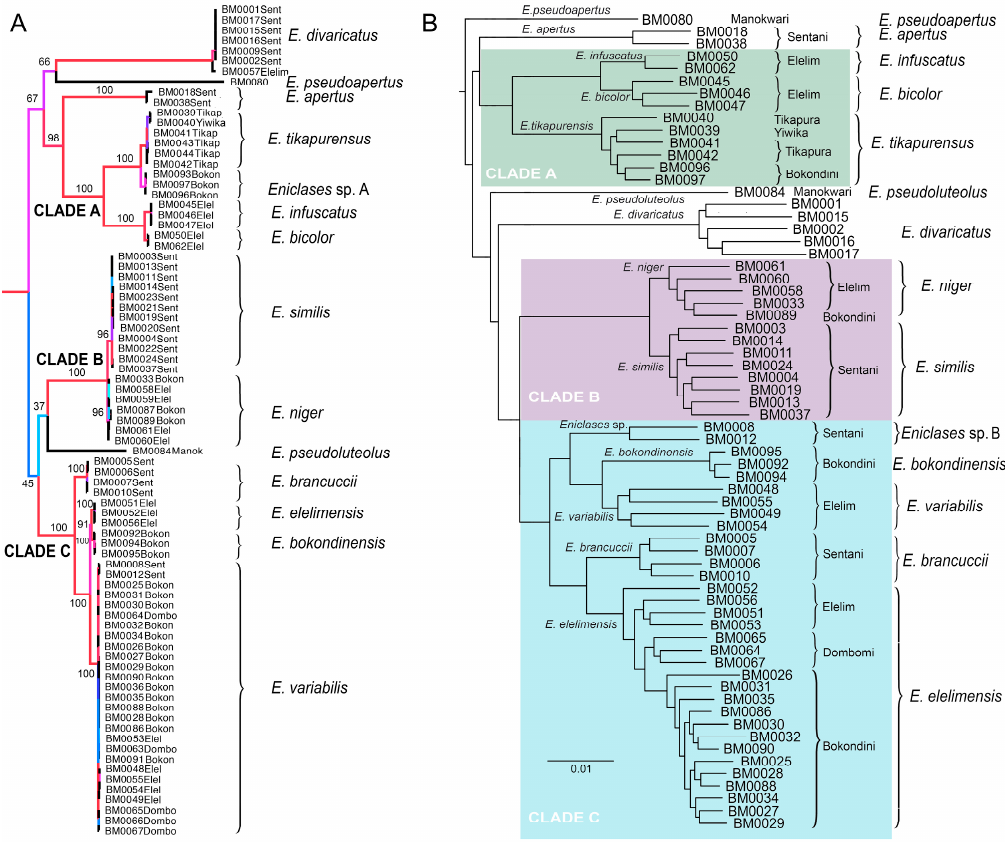
Figure 3. Maximum likelihood phylogenies of Eniclases . Nodes are colored according to ultrafast bootstrap values. The clades A, B and C designate lineages of closely related species whose delimitation is discussed in the text. ( A ) topology recovered by the analysis of three mitochondrial DNA fragments; ( B ) topology recovered by the analysis of RAD dataset (Wclust = 0.85, MinCov = 4). Species limits follow Bocak and Bocek (2016) in Figure ( A ) and the results of RAD analysis in Figure ( B ). Labels at terminals designate voucher numbers and geographic origin.